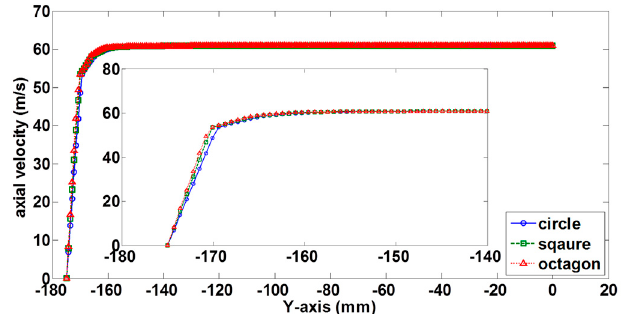
Figure 12. Axial velocity profiles at contraction exits (CT #1).